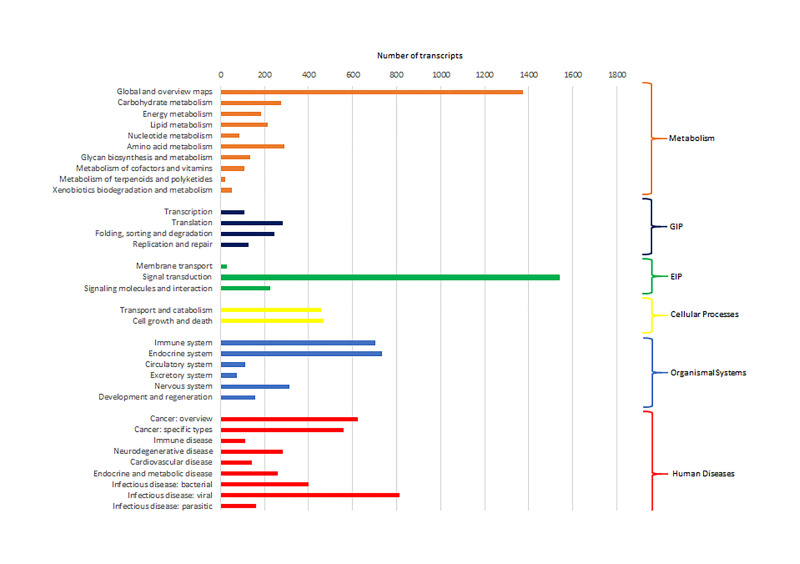
Number of pacu transcripts (x-axis) assigned to each KEGG pathway arranged in the y-axis. The categories GIP and EIP stand for “Genetic Information Processing” and “Environmental Information Processing.”